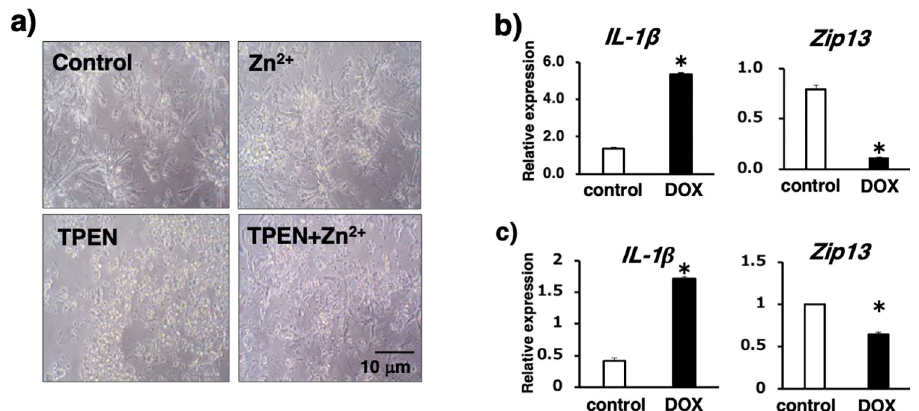
Fig 1. Effects of zinc level alteration and Dox stimulation on PNCs. (a) Effect of either zinc depletion or supplementation on the morphology of PNCs cultured in media containing 10 μ M TPEN or 100 μ M ZnSO 4 for 24 h. Representative images are shown (n = 3–4; scale bar = 10 μ m). (b) Effect of Dox treatment on Il-1 β and Zip13 expression in PNCs. PNCs were cultured with or without Dox (10 ng/mL) for 24 h. (c) Effect of Dox treatment on Il-1 β and Zip13 expression levels in heart tissues of mice. C57BL/6J mice were intraperitoneally injected with Dox (15 mg/ kg), and heart tissue samples were collected two weeks after Dox injection. All data were collected from three to four independent experiments. Significant differences were analyzed using the Student’s t -test for each experimental group ( � p < 0.05).